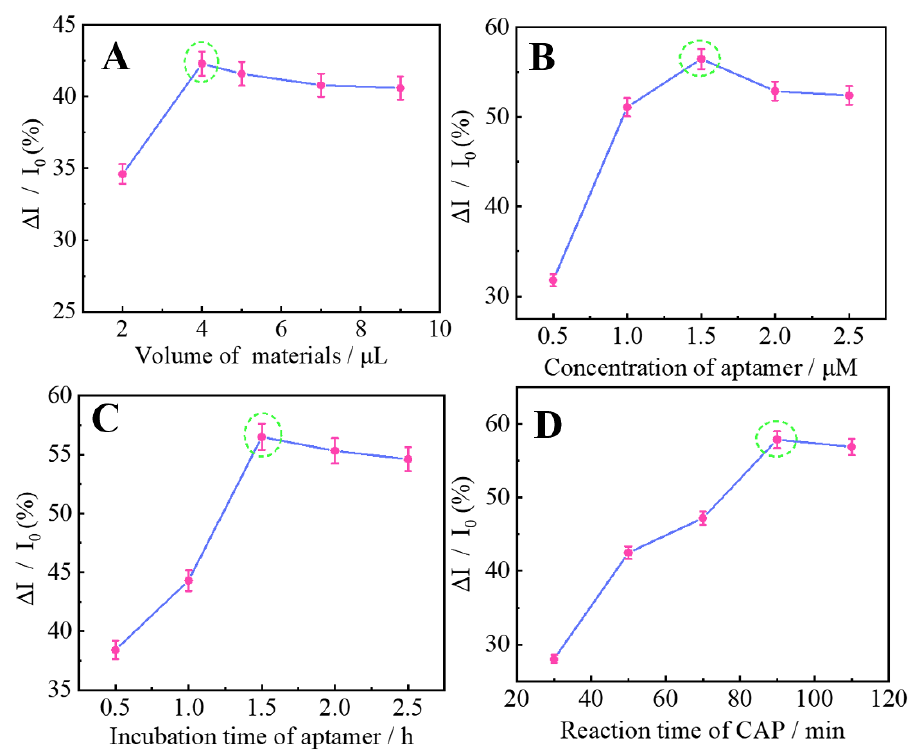
Figure 4. The optimization of ( A ) the volume of AuNPs/PCs, ( B ) the concentration of aptamer, ( C ) the incubation time of aptamer, and ( D ) the incubation time of CAP.